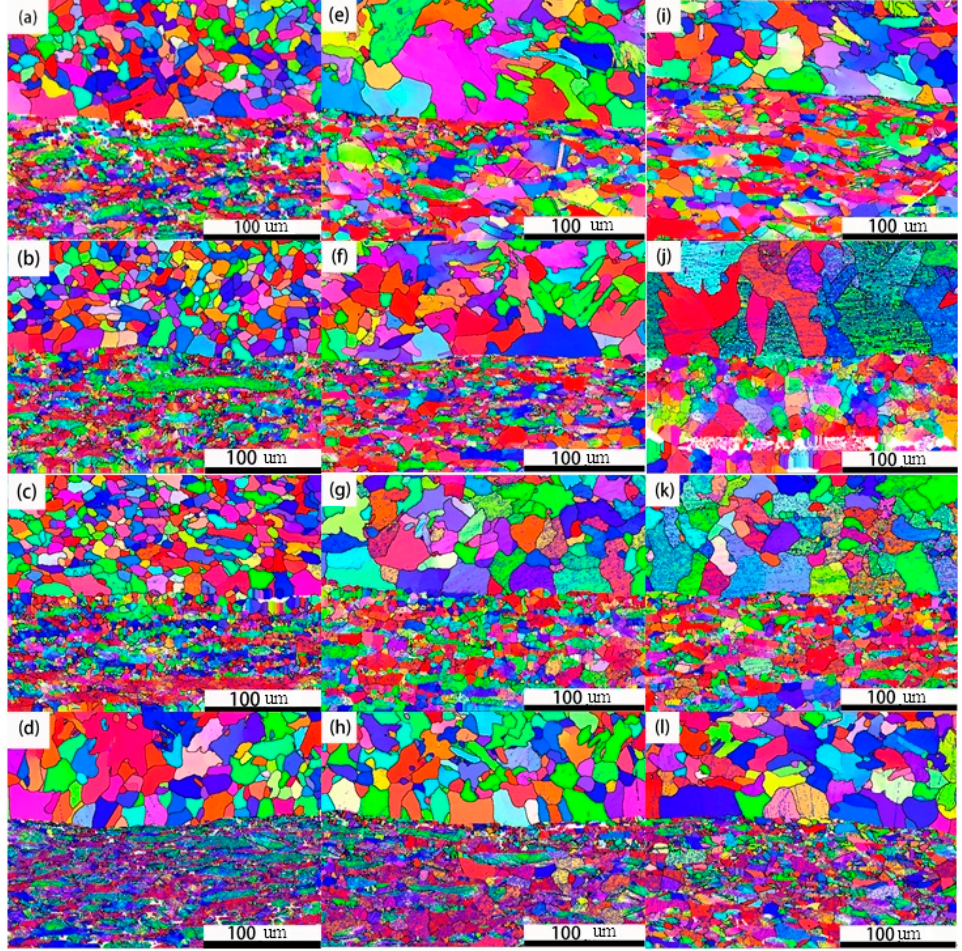
Figure 6. Composite interface IPF for 1000 times large deformation area ( a ) 850 °C, 0.01 s − 1 ; ( b )